Question: Which kind of chart has been used to present this data?
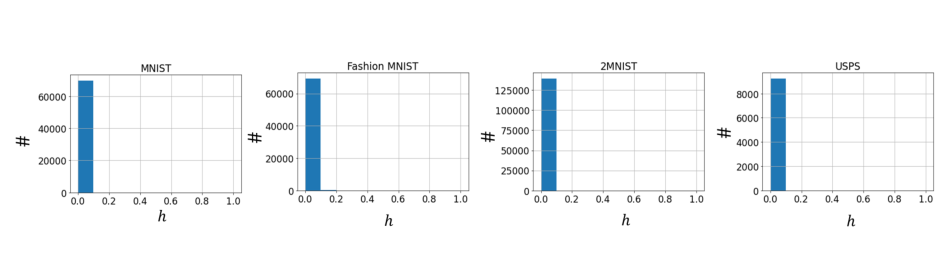
Answer: histogram